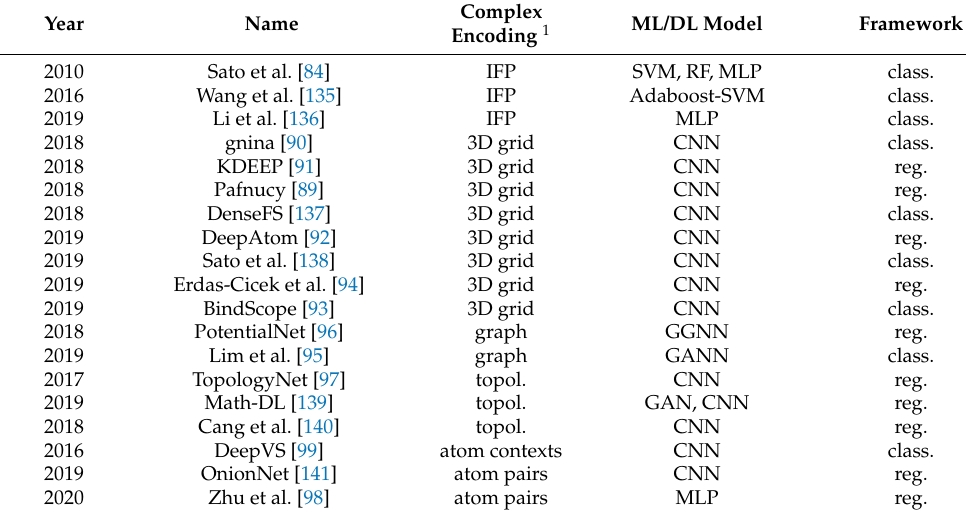
Table 3. Complex-based models. Summary of recent work using a protein-ligand complex for active molecule or binding affinity prediction. The year of publication, the name of the authors or the model, the complex encoding and the machine/deep learning model(s) are shown in the respective columns. Classification (class.) implies predicting e.g. hit or non-hit, whereas regression (reg.) evaluates e.g., pIC 50 values. CNNs, coupled with 3D grids, have become frequent in state-of-the-art